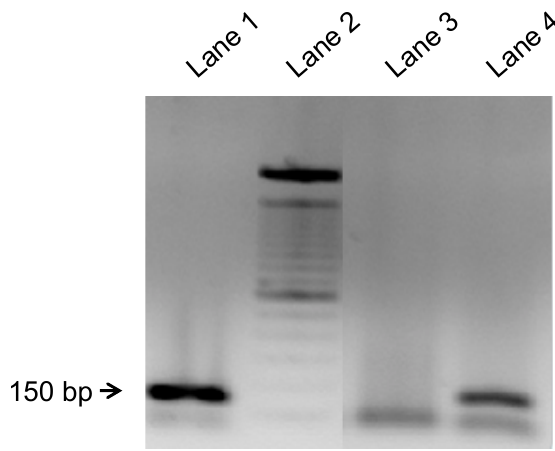
Figure 7. Representative analysis of nested polymerase chain reaction (PCR) for defining the presence of transplanted male rat BM-MSCs in the female recipient maxillary using the sex-determining region of the Y chromosome as a quantification marker. PCR amplification products were 150 bp. Lane 1: positive control (liver cells from male rats); Lane 2: 100 bp DNA ladder; Lane 3: maxillary cells from female rats transplanted with saline + β -TCP scaffold; Lane 4: maxillary cells from female rats transplanted with BM-MSCs + β -TCP scaffold.